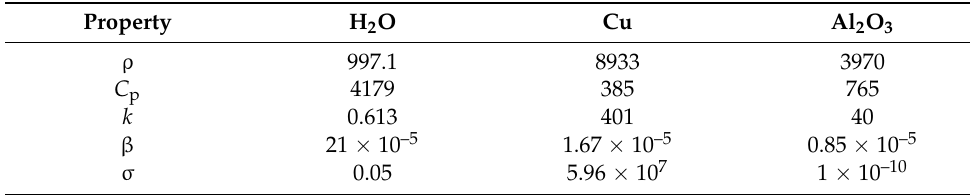
Table 1. Properties of the components of the hybrid nanofluid. Property H 2